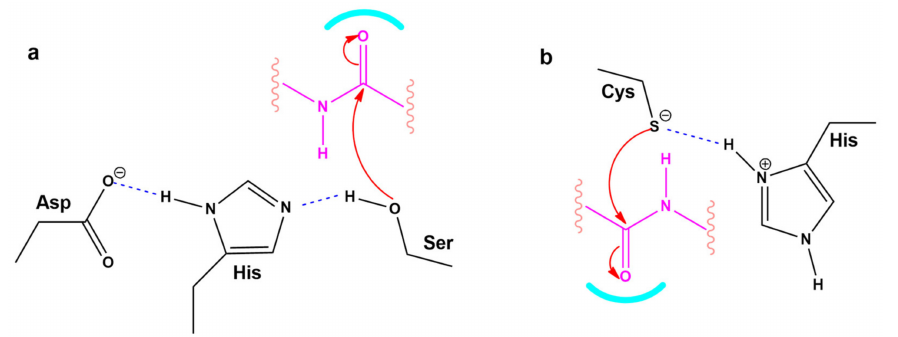
Figure 15. CRS Protease mechanisms. SARS-CoV-2 S protein can be cleaved by furin at